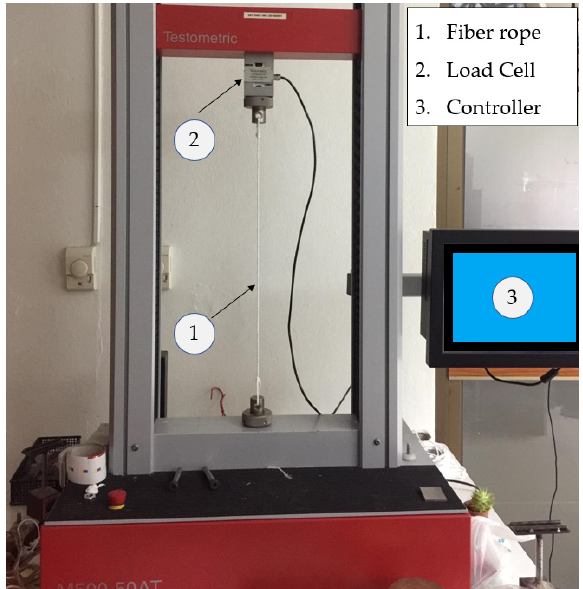
Figure 2. Setup for tensile tests.